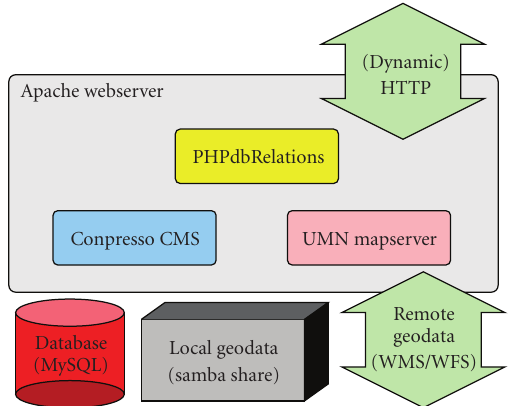
Figure 1: Behind the scenes of our data management. Using the apache web server [15] and a MySQL [14] database, we are using the “ConPresso Content Management System” [16] for static content . Dynamic content is managed using the PHPdbRelations toolkit [17] with its export routines for HTML and XML through PHP [18] (see also Williams and Lane [19]). For web mapping, the UMN MapServer [4] (refer also to Mitchell [20] and Erle et al. [21]) is used via the PHP/Mapscript [22]